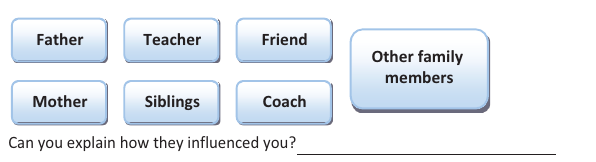
CARDS (Interviewee to arrange in rank order and interviewer to record final decision)